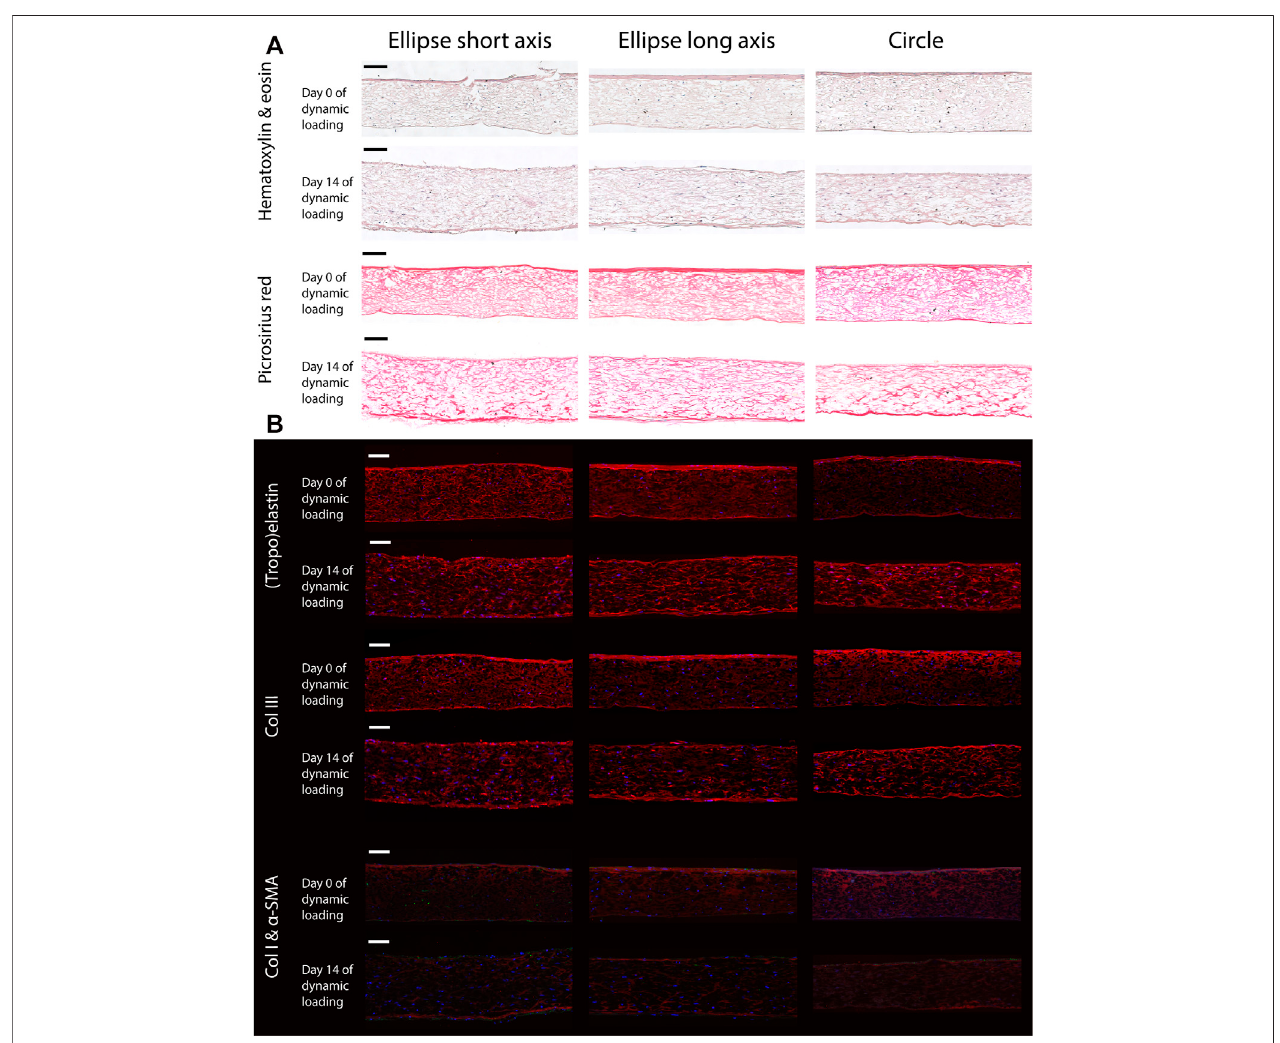
FIGURE6| Representativehistological (A) and immunohistochemical (B) cross-sectionsalongtheshort andlongaxisoftheellipticalconstructs,andthediameter of the circular samples, before (day 0) and after (day 14) dynamic loading. Note that the bottom side of all samples coincides with the pressurized side in the bioreactor. Scale bars represent 100 μ m. (A) The top two rows show a Hematoxylin and Eosin staining to indicate the general tissue composition and cellular distribution. The bottom two rows feature a PR stain, depicting collagen fi bers (red). (B) From top to bottom; elastin (red), collagen type 3 (red), collagen type 1 (red) and α -SMA (green). In all images cell nuclei are stained blue. Negative controls for immunohistochemical images can be found in Supplementary Figure S3 .